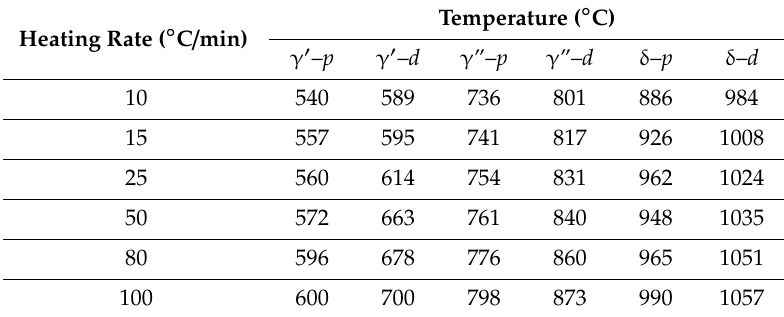
Figure 8. DTA records obtained on the as-SLM IN718 upon heating at scanning rates of 10, 15, 25, 50, 80, and 100 °C/min up to 1200 °C. The subscripts “d” and “p” represent the dissolution and precipitation temperatures of the corresponding phase. Table 3. Variation of precipitation ( p ) and dissolution ( d ) temperatures of γ’, γ”, and δ phases in the SLM-IN718, for different heating rates.